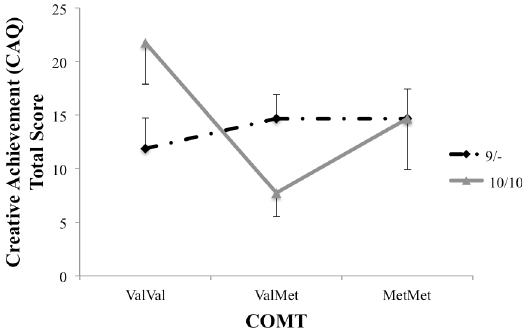
Fig 5. Estimated marginal means for creative achievement (CAQ) total scores, controlling for academic